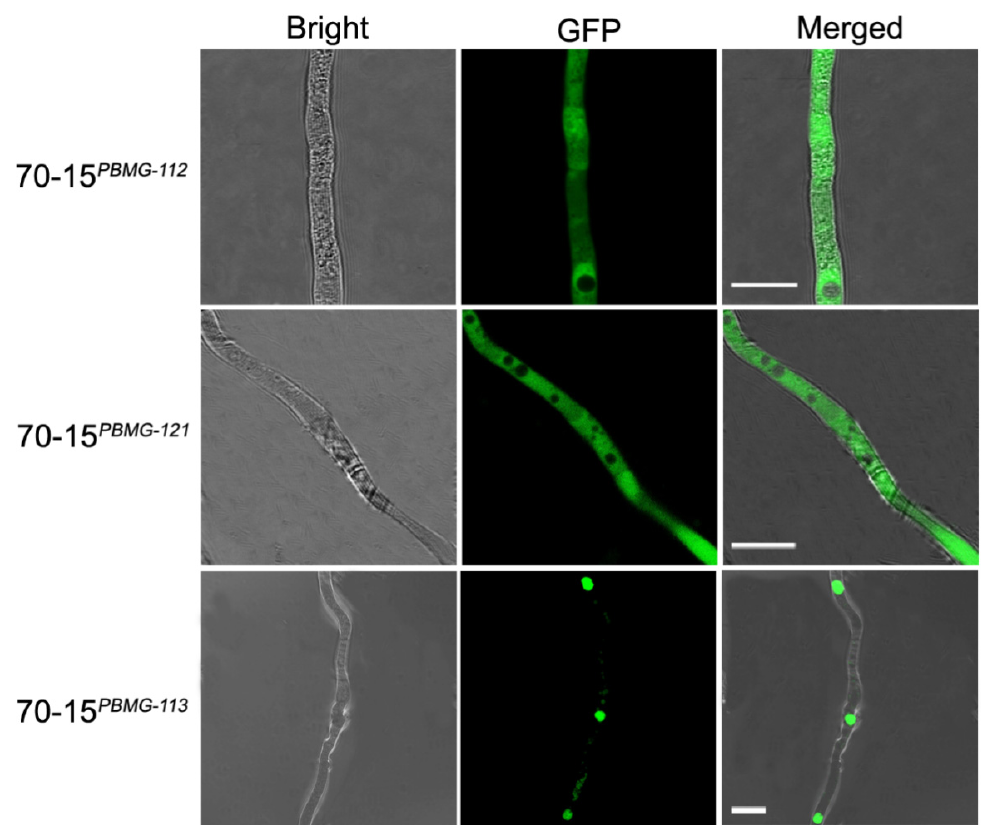
Figure 3. Subcellular distribution of the MAT proteins in 70-15 were detected using the GFP fusion method. The GFP fluorescence in hyphae of 70-15 PBMG-112 , 70-15 PBMG-121 and 70-15 PBMG-113 was observed under a fluorescence microscope. MAT1-1-3 is distributed in the nucleus while MAT1-1-2 and MAT1-2-1 are cytosolically distributed. Bars = 10 μ m.